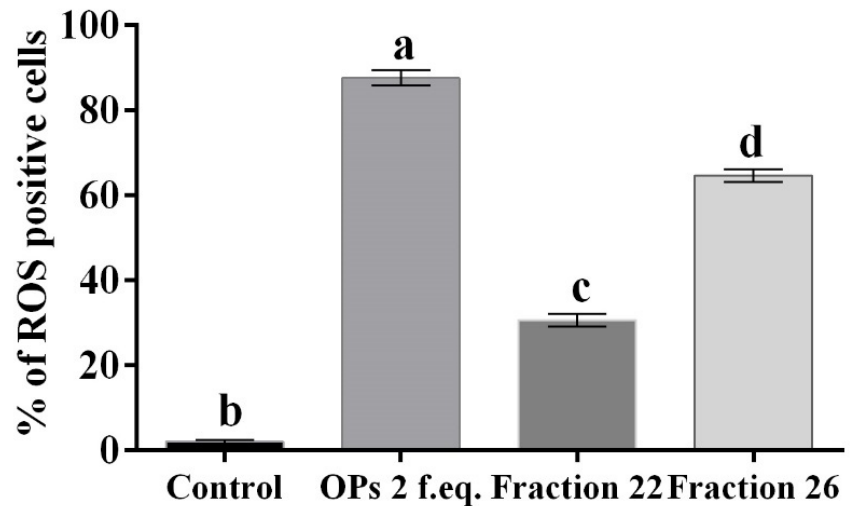
Figure 8. Percentage of hemocytes stained with H 2 DCFDA showing oxidative stress, after treatment with 1X PBS (control), OPs deriving from two equivalent females (2 f. eq.), HPLC fractions #22 and #26. Data are reported as mean ± SD of n = 3 independent experiments. Statistical analysis was performed with one-way ANOVA and Bonferroni post hoc test. Different letters indicate significant differences ( p value < 0.0001).